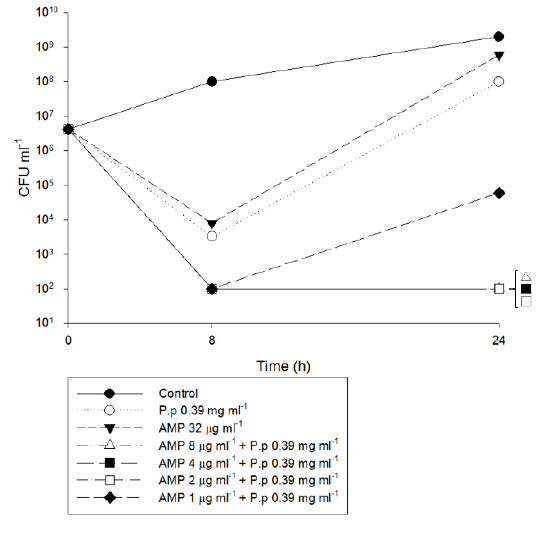
forming units (CFU) mL − 1 . Note. GM, gentamicin.